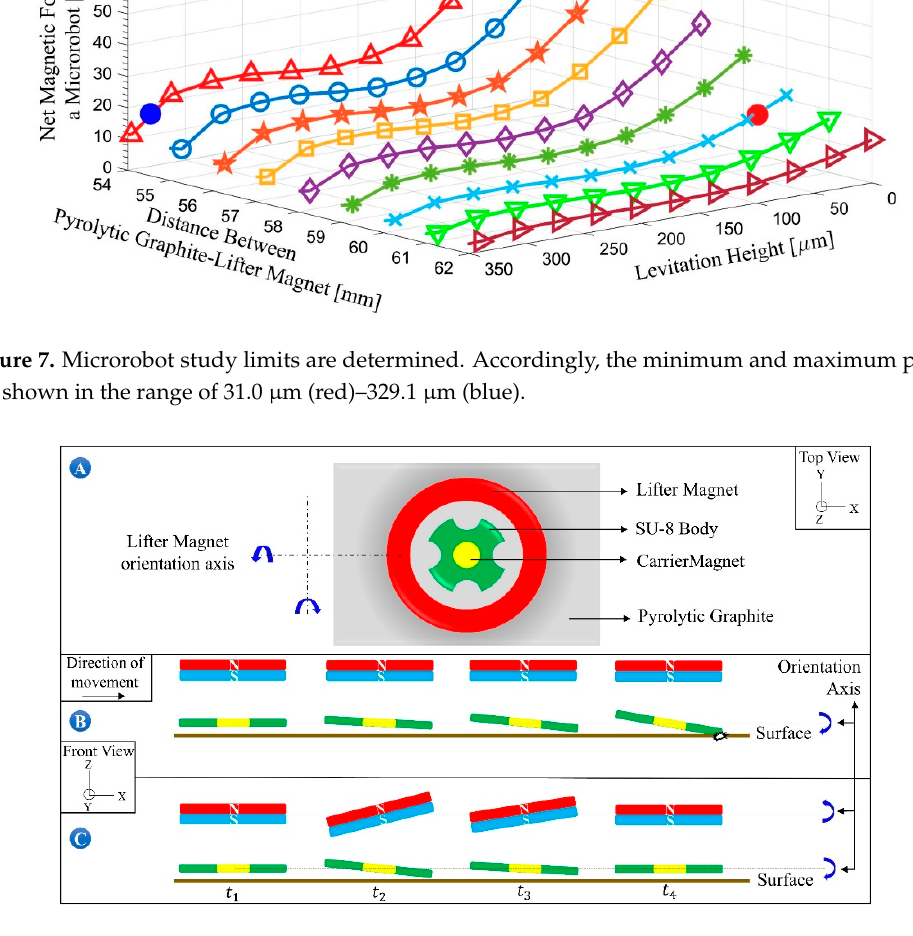
Figure 8. Roll and pitch axes control the orientation of the microrobot to eliminate head-tilting reaction ( A ); result of the uncontrolled microrobot motion is given in ( B ), and the head-tilting reaction can be eliminated by adjusting carrier-magnet orientation ( C ).